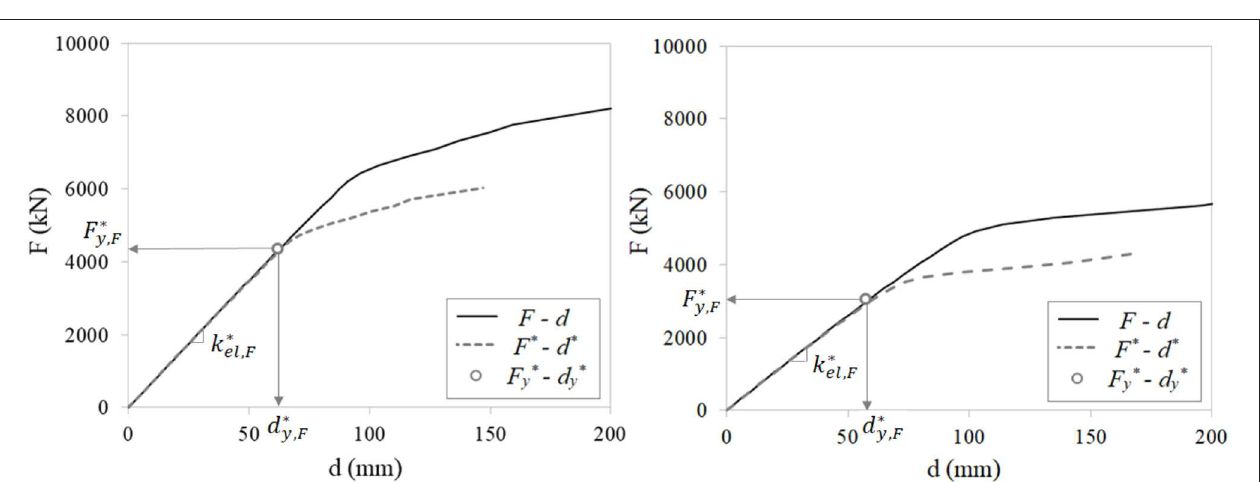
FIGURE 4 | Physical l ( F-d ) and reduced ( F * -d *) capacity curves calculated for the bare frame of block A along longitudinal (X, left) and transversal (Y, right) directions.